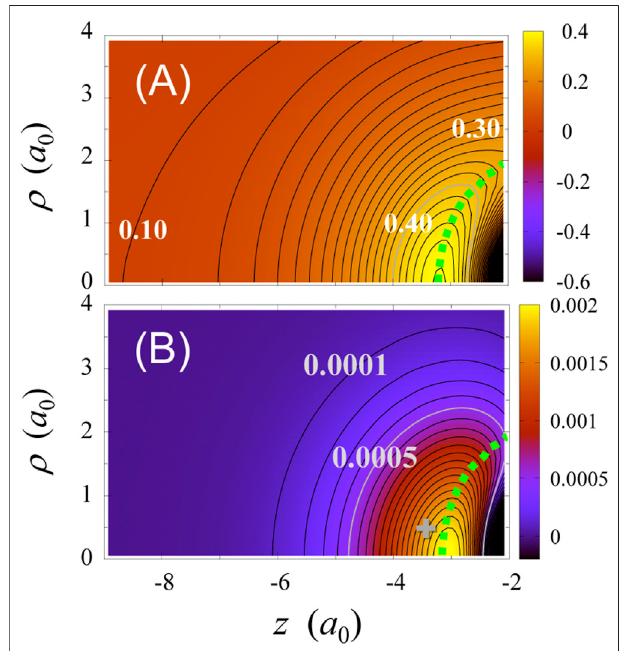
FIGURE 5 | TD-CASSCF results for the pulse in Figure 3C : (A) 2D contourplotof υ 1 ( 0 ) + υ 2 , 5 σ ( t ) at t ≈ 2.8fs; (B) Contourplotofthedifferencein total electron density between t ≈ 2.8 and t (cid:2) 0. The contour lines in (A) are drawn at height intervals of 0.02 E h . The numbers near contour lines indicate the heights (in units of E h ). The contour lines in (B) are drawn at intervals of 0 . 0001 a − 3 0 . The symbol “ + ” designates that the electron density increases in the region. The hump ridgeline in υ 1 ( 0 ) + υ 2 , 5 σ ( t ) is schematically illustratedin (A) byalightgreendottedline,whichisalsodrawnonthecontour plot (B) as a dotted line.